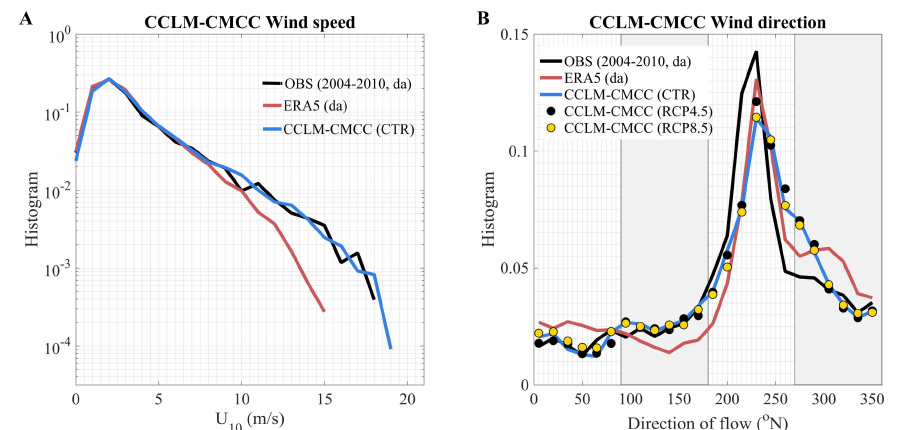
Figure 6. Performance of CCLM-CMCC horizontal wind speed and direction (CTR run, blue line). Comparison with in situ observations (OBS, black line) and ERA5 data (red line) in the northern Adriatic Sea (Acqua Alta oceanographic platform, AA). ( A ) Relative frequency histogram of daily average (da) wind speed ( U 10 , in m/s). ( B ) Relative frequency histogram of daily average wind direction of flow. For comparison, future scenario simulations’ histogram values from RCP4.5 and RCP8.5 are shown with black and yellow markers, respectively.